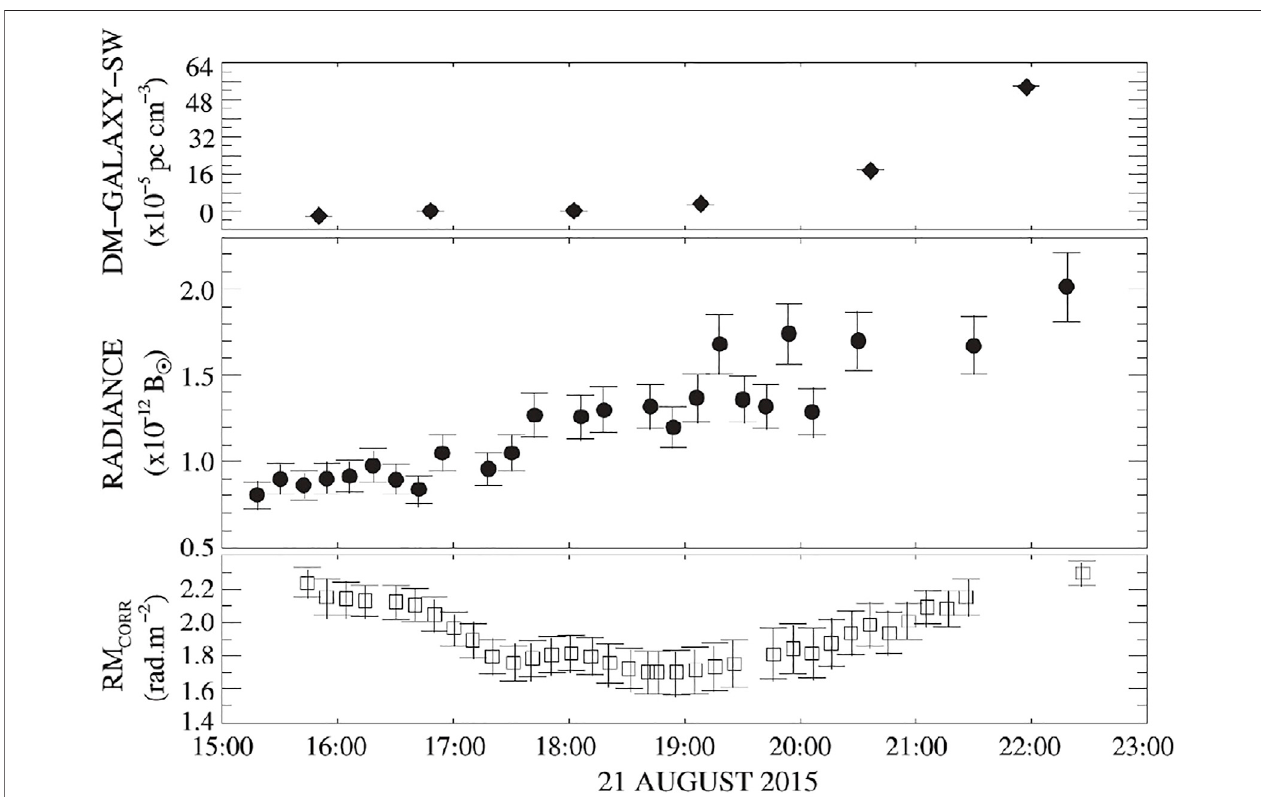
FIGURE 8 | Observations of CME FR using a pulsar. Top, middle, and bottom panels give the dispersion measure (DM), radiance (i.e. TSB), and FR, respectively, due strictly to the corona and CME. At these heliocentric distances ( ≈ 18R ⊙ ) , the coronal DM is a factor of ≈ 10 4 smaller than the interstellar DM and the coronal RM is comparable to the ionospheric RM. These data correspond to values reported for 2015 August 21 i in Table 3 . This appears as Figure 7 in Howard et al. (2016), ©AAS, reproduced with permission.